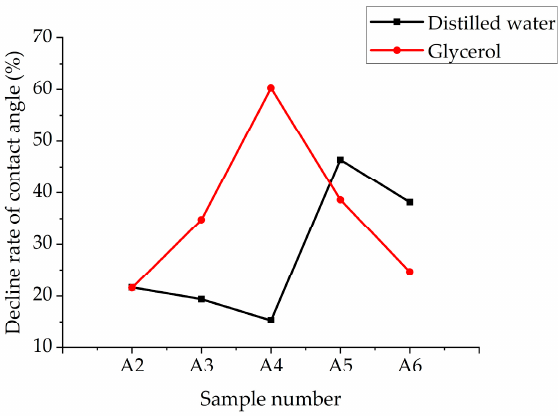
Figure 4. Trend graph of the decline rate of contact angle between glycerin and distilled water.